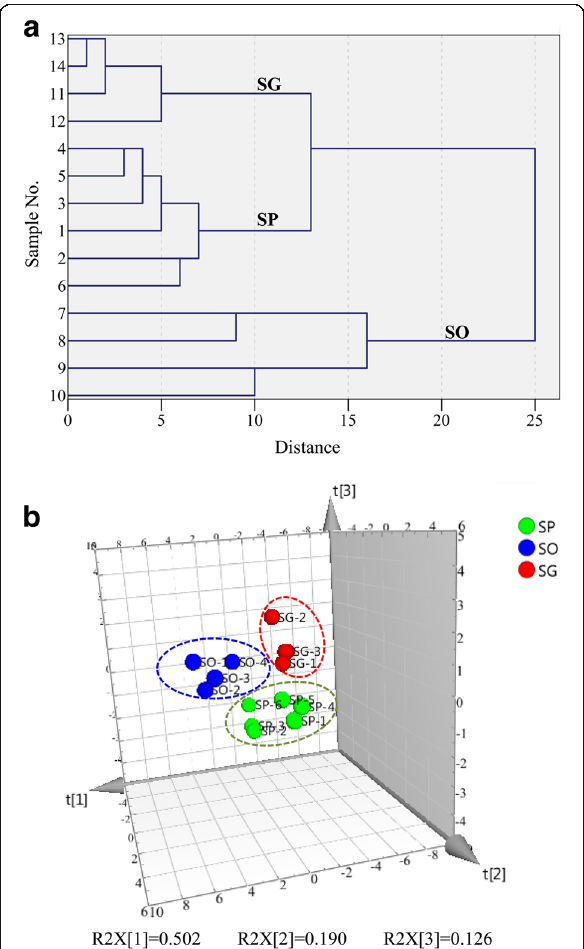
Fig. 2 Chemometric analyses of common peaks ’ intensities of samples 1 – 14. a Results of hierarchical clustering analysis. b Results of principal component analysis. The green, blue and red balls represent SP, SO and SG,